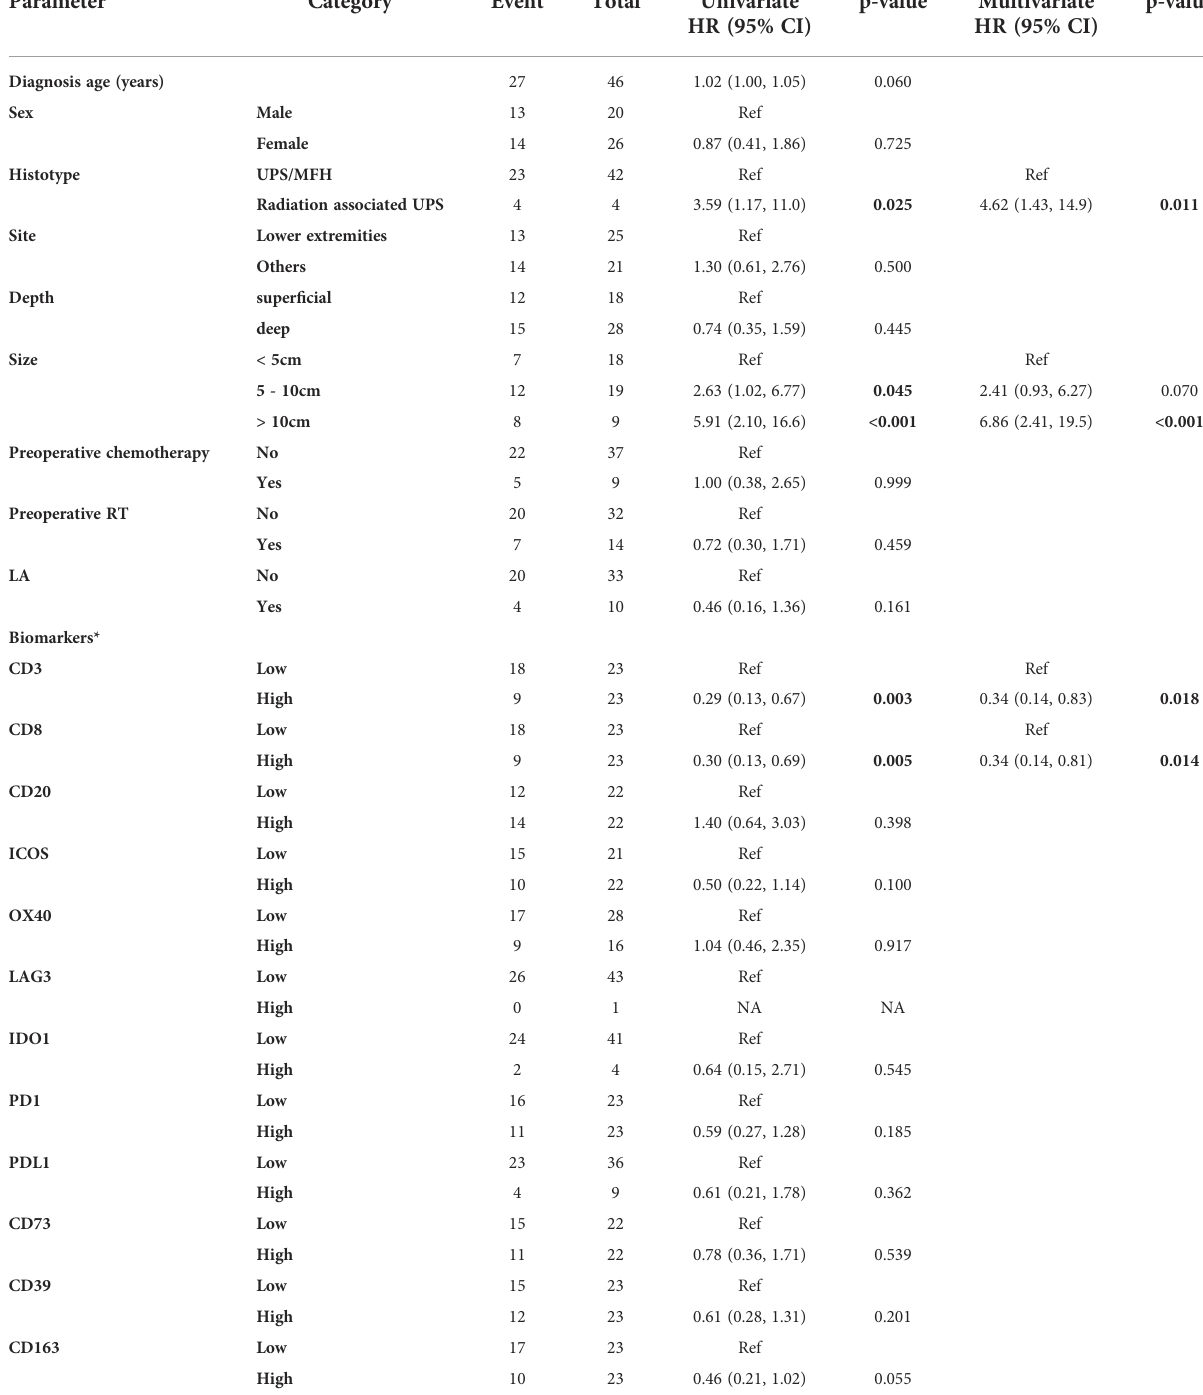
TABLE 5 Univariate and multivariate cox analyses for disease-free survival in primary